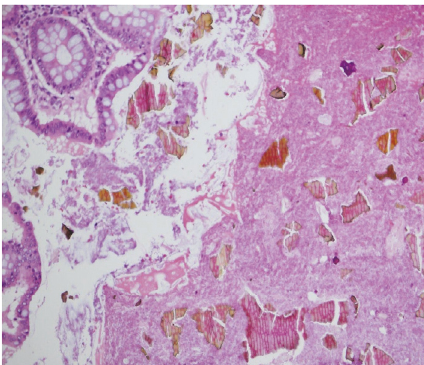
Figure 2: High power showing crystals deposition on hematoxylin and eosin stain